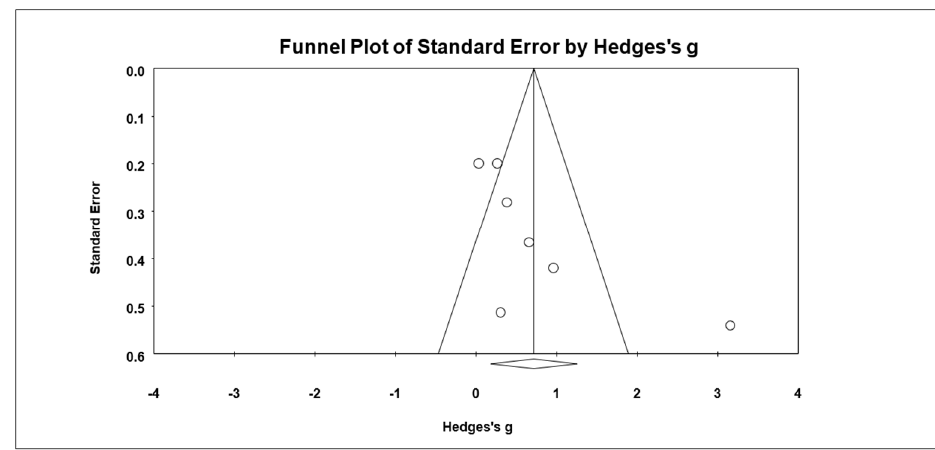
Figure 3. Funnel plot for ADHD symptoms.